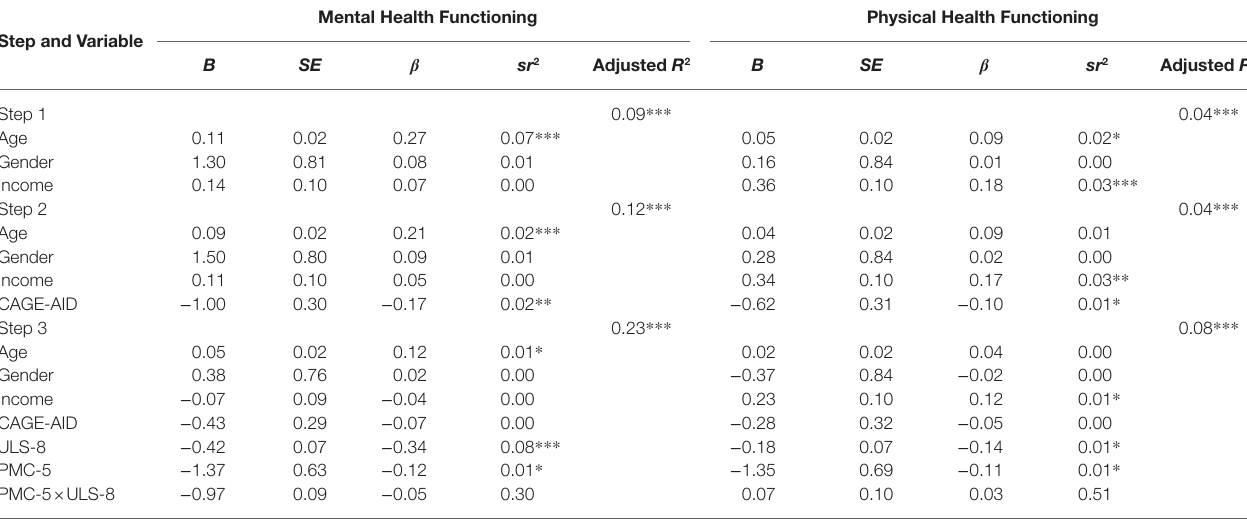
TABLE 6 | Summary of hierarchical regression analysis predicting mental and physical health functioning ( n =